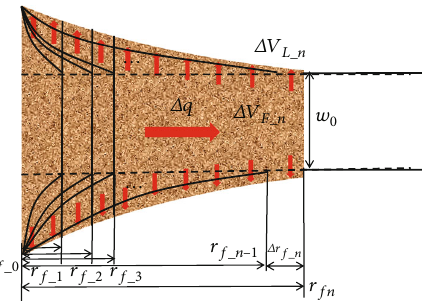
Figure 5: Schematic diagram of drilling mud loss in naturally fractured formation segments.